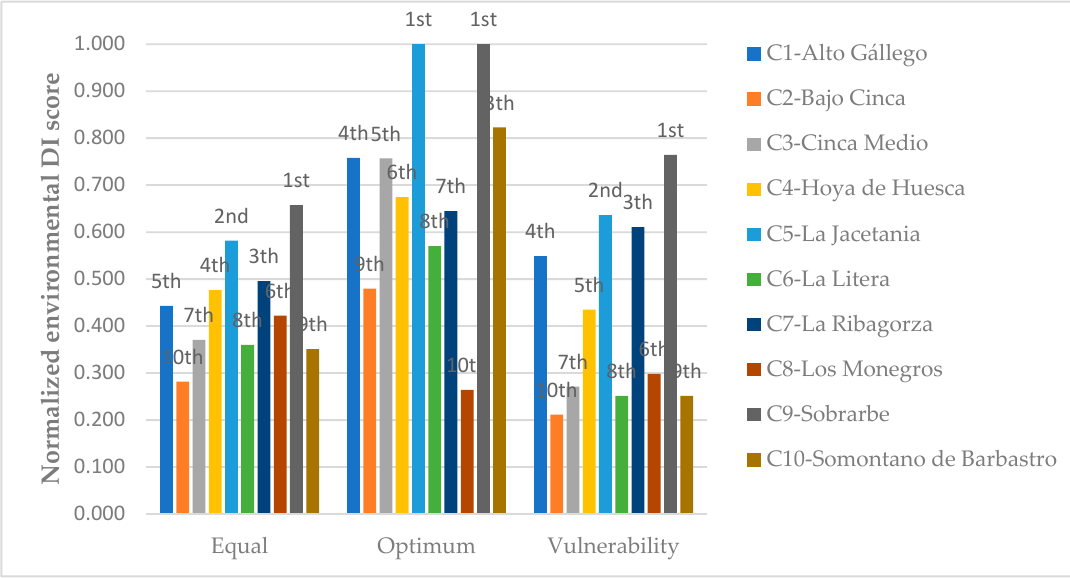
Figure 2. Normalized environmental dimension indicator scores by comarca and corresponding ranking position according to the process of calculating weights: vulnerability based weights and equal and optimal approaches.